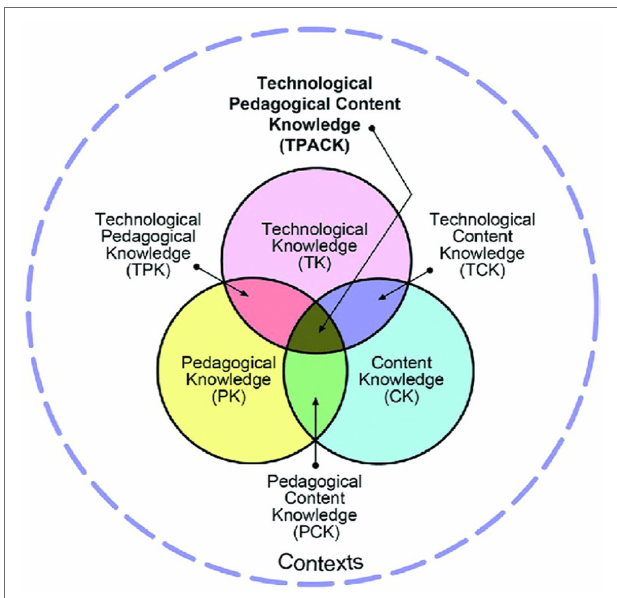
FIGURE 1 | The technological pedagogical content knowledge (TPACK) framework (retrieved from